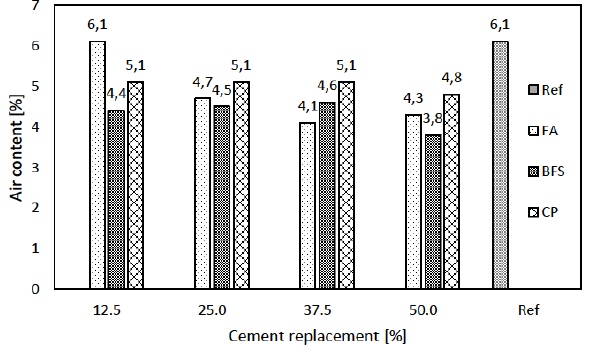
Figure 1: Air content in fresh mixtures